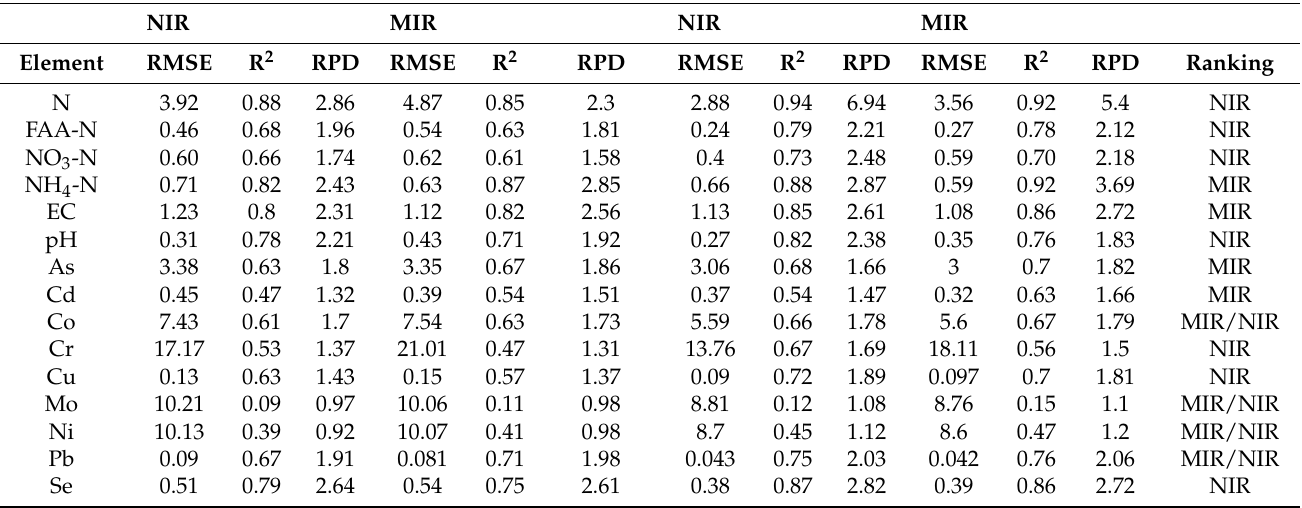
Table 2. The goodness of fit for essential nutrients for plants (N. P, K and plant-available form of nitrogen) and total elements derived from near-infrared (NIR) and mid-infrared (MIR) with and without wavelength selection. All units are g kg − 1 , except Cd, As, Cr, Se, Mo, and Ni in mg kg − 1